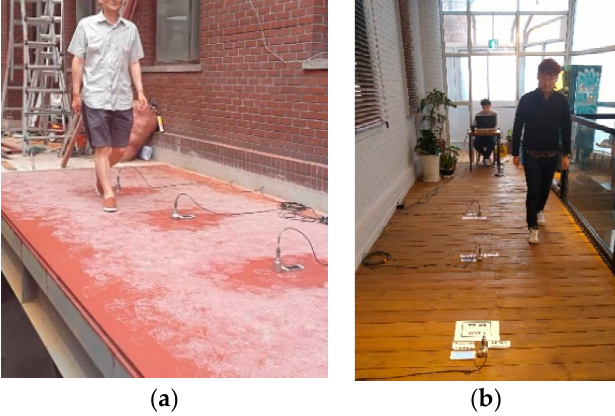
Figure 4. Japanese guidelines [11].